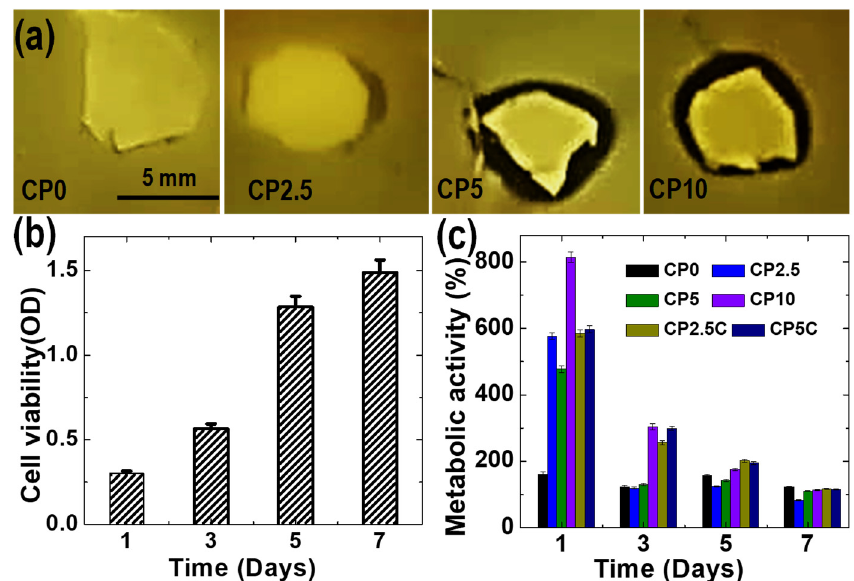
Figure 5. ( a ) Antibacterial activity of the scaffolds against S. aureus presented by zone of inhibition. ( b ) Cell viability results for the scaffold ‐ free 3D ‐ printed ring (control), presented by the optical density (OD) value for the MTT assays. ( c ) Cell metabolic activity of BM ‐ MSCs in the scaffold. The data were normalized according to Equation (4) and represented as mean ± SD ( n = 3).